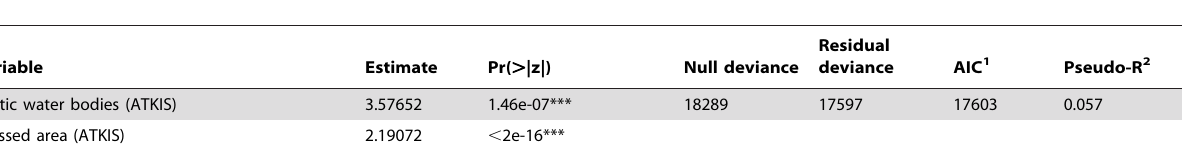
Table 4. Multivariate statistical analysis, final logistic regression model after controlled stepwise selection of variables.